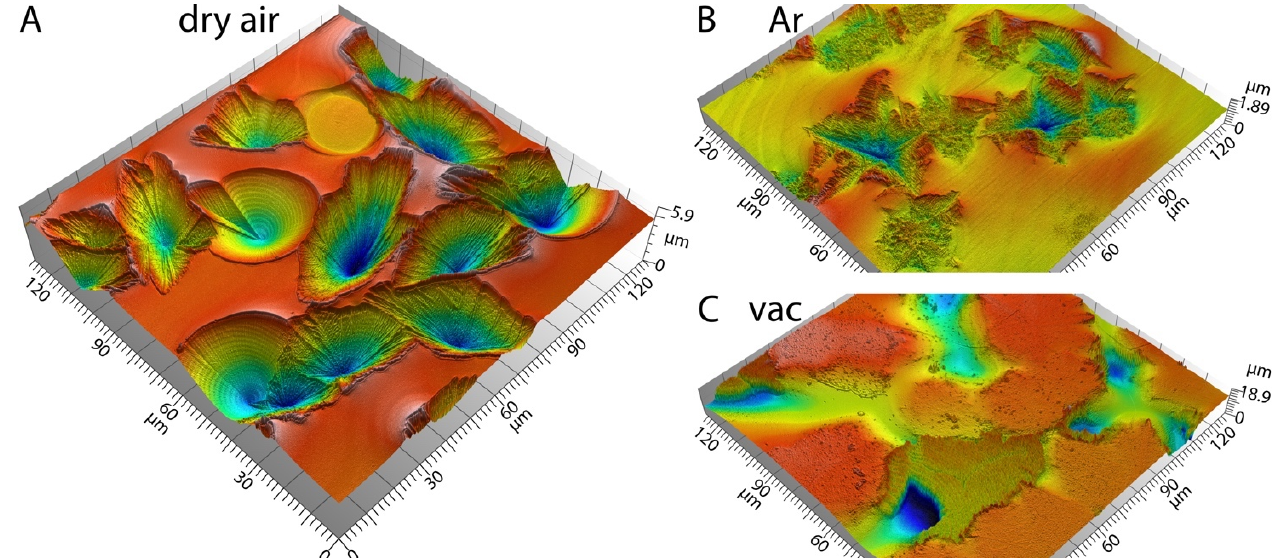
Figure 4. LSM 3D-images of crystallized surfaces in dry air ( A ), argon ( B ) and vacuum ( C ). The crystals and circular structures of the air and argon samples grow toward the bulk of the samples and form valleys. In vacuum, the crystals are the plateaus and the surrounding residual glassy matrix forms holes. Some branched crystals in argon atmosphere protrude from the surface.